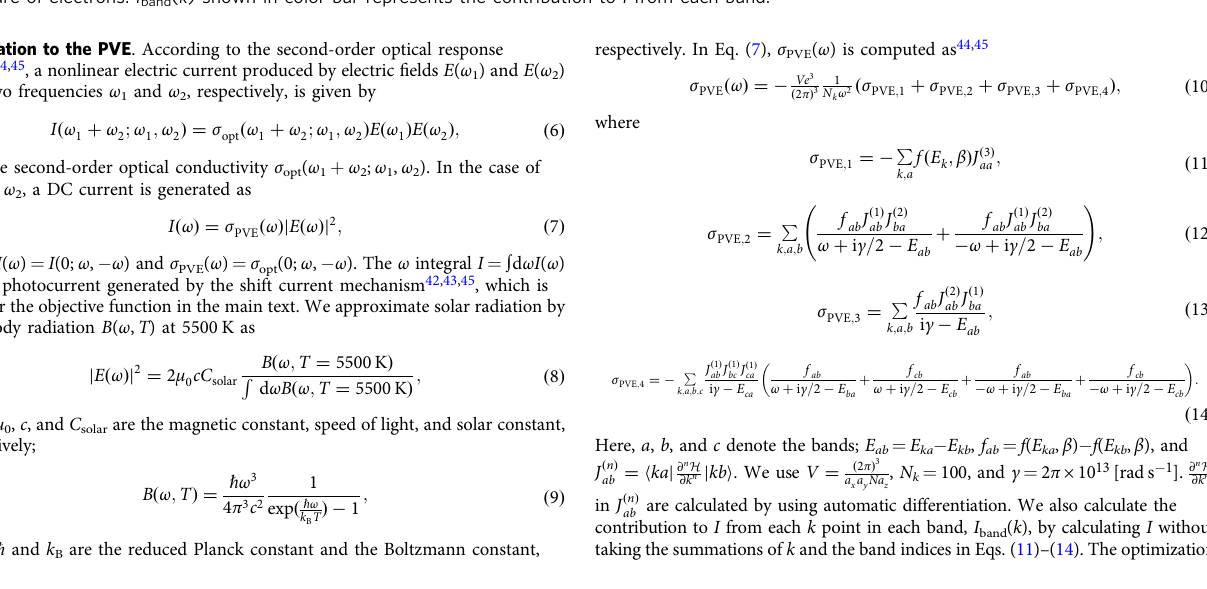
Fig. 4 Automatic construction of a Hamiltonian for electrons moving on a noncoplanar spin texture, which can generate~ 700 A m − 2 under solar radiation. a Schematic of the system. A photocurrent is generated by solar radiation (blackbody radiation at 5500 K in the inset) onto the one-dimensional spin-charge coupled system. b Schedule of temperature T [K]. c Change of the photocurrent I [A m − 2 ]. The insets show the changes of the nearest- neighbor hopping t 1 [eV], the second-neighbor hopping t 2 [eV], and the coupling constant J [eV]. d – f Spin con fi gurations after the convergence ( d ), plotted with the z components S z ( e ) and the angles of spins projected onto the xy plane, ϕ S ( f ). The S z axis is taken in the direction of the total magnetization. g ω xy dependence of I ( ω ) = σ PV E ( ω ) ∣ E ( ω ) ∣ 2 , where σ PVE ( ω ) is the nonlinear optical conductivity and ∣ E ( ω ) ∣ 2 is the intensity of solar light (inset). h The band structure of electrons. I band ( k ) shown in color bar represents the contribution to I from each